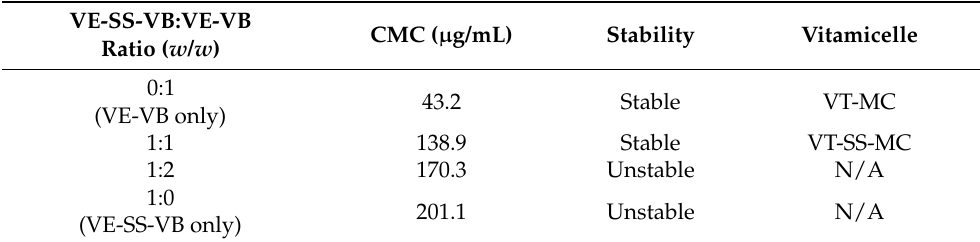
Table 1. Changes in the CMC of vitamicelles as a result of incorporating VE-VB into VE-SS-VB at different weight ratios.